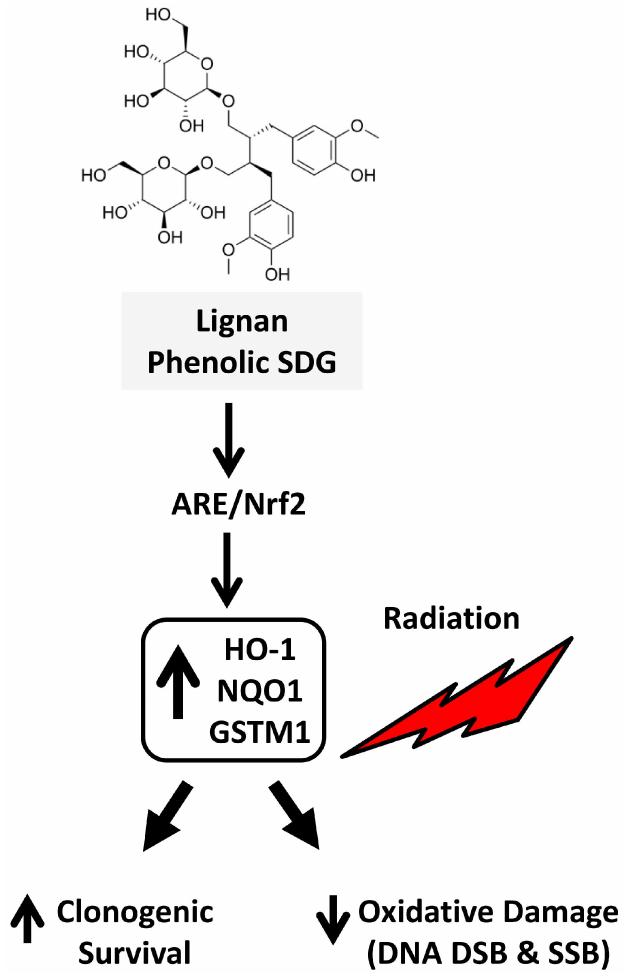
Figure 6. Schematic representation of possible mechanism by which lignan phenolic SDG (LGM2605) protects lung cells against radiation exposure. SDG upregulates the phase II cytoprotective enzymes, HO-1, NQO1 and the gene levels of GSTM1; thus, when the non-malignant lung cells are exposed to ionizing radiation, less oxidative damage is induced, leading to increased clonogenic survival of the irradiated